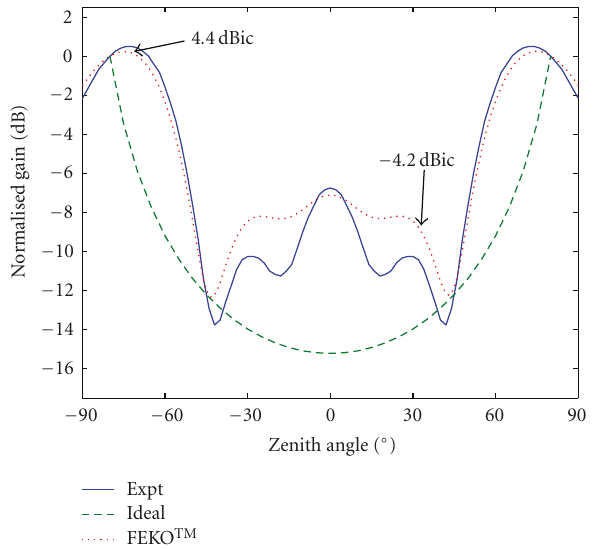
Figure 4: Radiation pattern of the helical antenna on 1.8m sided square ground plane at 479MHz, normalised to zenith 80 ◦ gain; “ideal” trace would compensate for free-space loss.